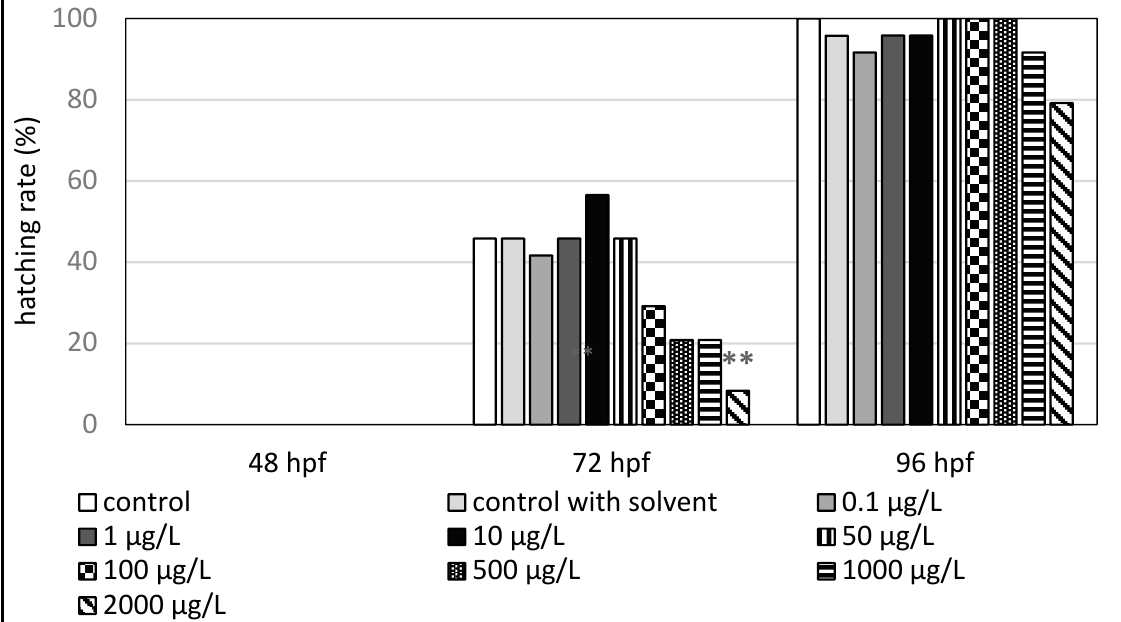
Figure 2. Hatching rate (%) of zebrafish embryos exposed to octocrylene (hpf—hours post fertiliza- tion). The asterisk indicates a significant difference (* p < 0.05) between the control and experimental groups at the same time of exposure. Figure 3. Hatching rate (%) of zebrafish embryos exposed to 4-methylbenzylidene camphor (hpf—hours post fertilization). The asterisk indicates a significant difference (** p < 0.01) between the control and experimental groups at the same time of exposure.